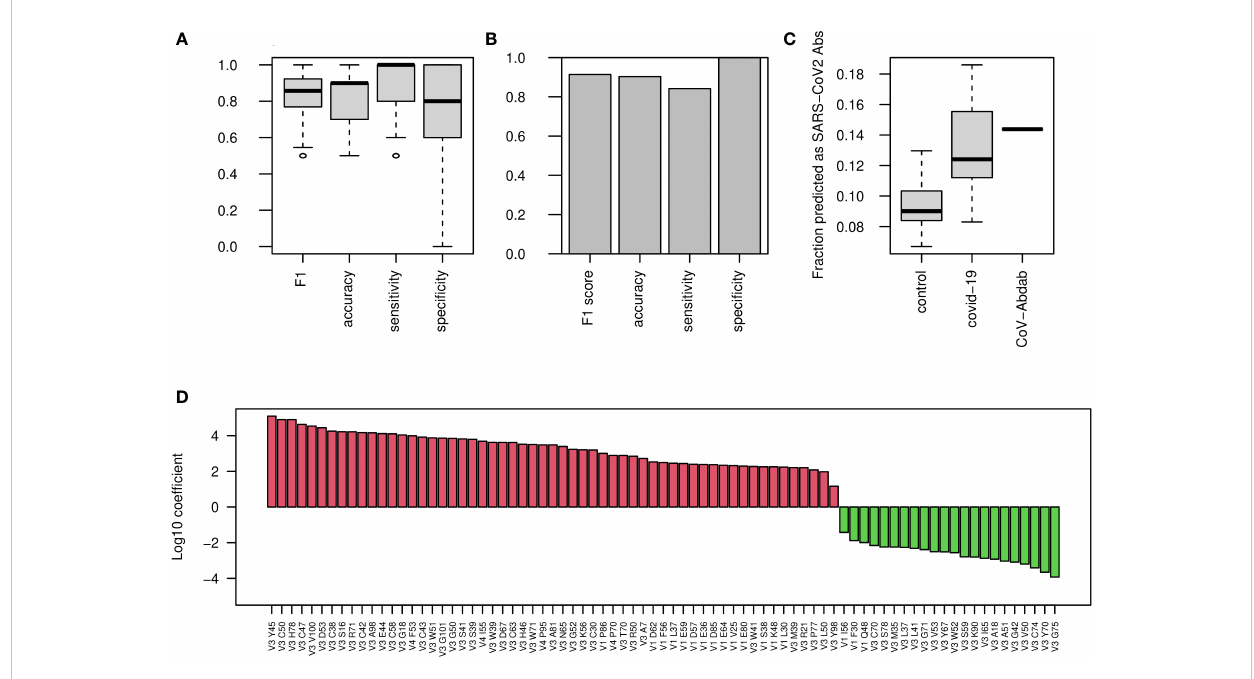
FIGURE 2 COVID-19 classi fi cation using AA frequencies at all V gene positions. (A) Boxplots showing the F1 score, accuracy, sensitivity, and speci fi city for COVID-19 classi fi cation by AA frequency at each position in each V family. Shown are values calculated for 50 random splits to train and validation groups. (B) Bar plots showing the indicated scores on the external test group. (C) COVID-19 single antibody scores were calculated using the coef fi cients of the algorithm described in panel (A) Boxplos showing the fraction of antibody sequences with scores above 0 in control and